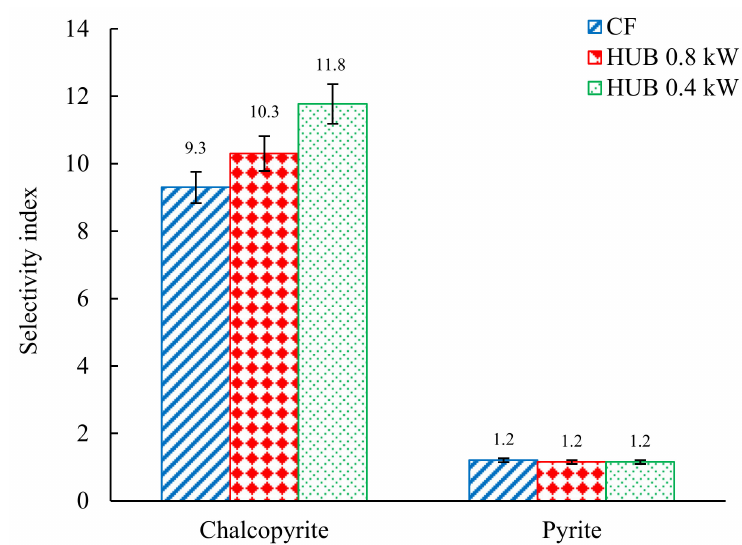
Figure 5. The SI values obtained for chalcopyrite and pyrite at three di ff erent configurations in the rougher flotation stage.